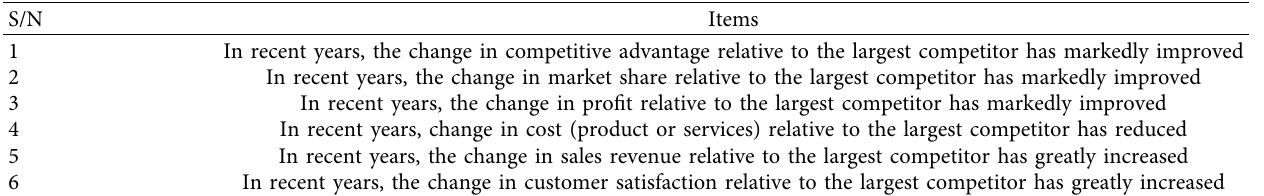
Table 2: Organization performance framework.